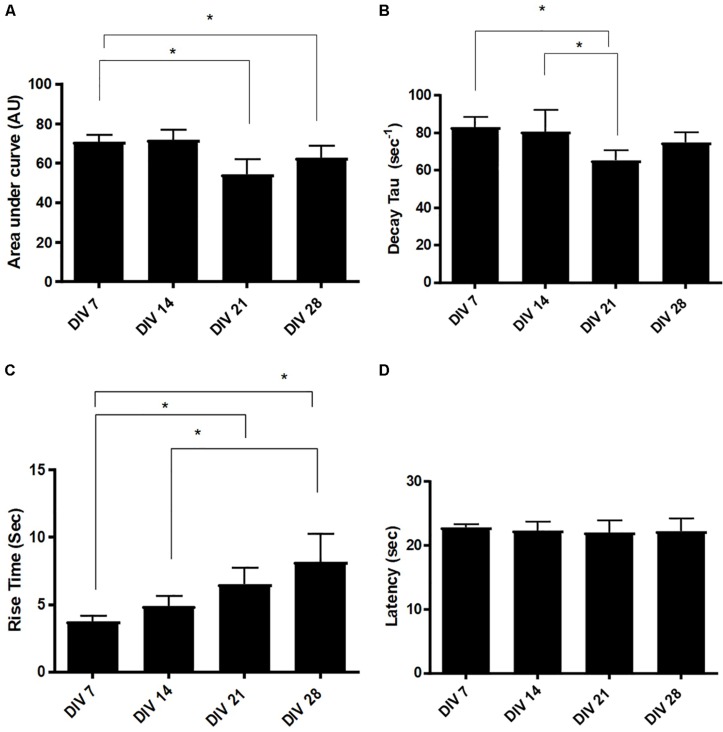
Evolution of Ca2+ transient parameters in mESC derived astrocytes. (A) Area under the curve (AUC), (B) decay tau (DT), (C) rise time (RT), and (D) latency. Statistical analysis reveals a significant increase in response RT from DIV7/14 to DIV 21 and DIV 28. Latency remains stable across different days in vitro (AU, arbitrary units, data expressed as mean ± SEM from three separate experiments, n = 30 astrocytes, ∗P < 0.05).